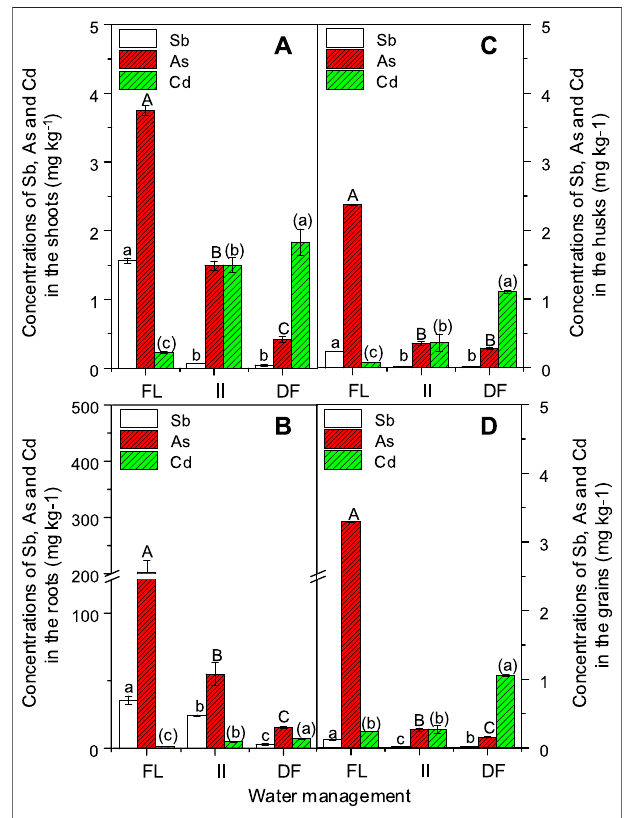
FIGURE 5 | Effect of different water management on the concentrations of Sb, As and Cdshoots, roots, husks and grains. Bars are means and standard deviations for three replications. Different lowercase letters, capital letters, and parenthesized letters denote signi fi cant differences (at p ≤ 0.05) forSb, As,andCdconcentrationsintheshoots,roots,husksandgrains among different treatments,